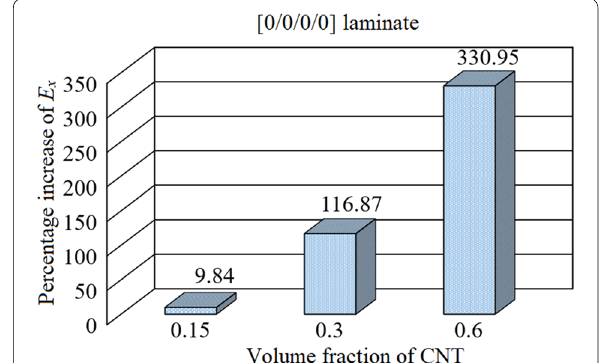
Fig. 5 Percentage increase in E x of CNT/epoxy with volume fraction as compared to CF/epoxy at a constant 60% CF volume fraction for [0/0/0/0] stacking sequence of laminate